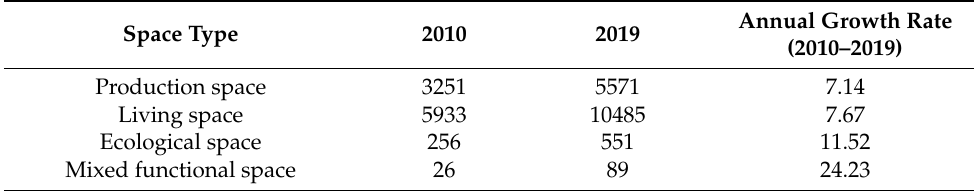
Figure 3. Identification of production–living–ecological spaces in Hangzhou in 2010 and 2019. Table 4. The number of PLE spaces in Hangzhou in 2010 and